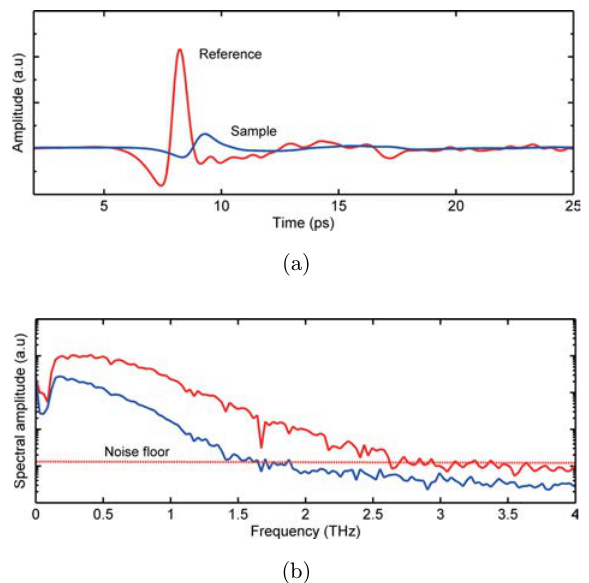
Fig. 2. Typical temporal waveform and frequency spectral for a reference and a sample signal. A bandwidth of up to 1.6 THz is obtained from our experimental setup.